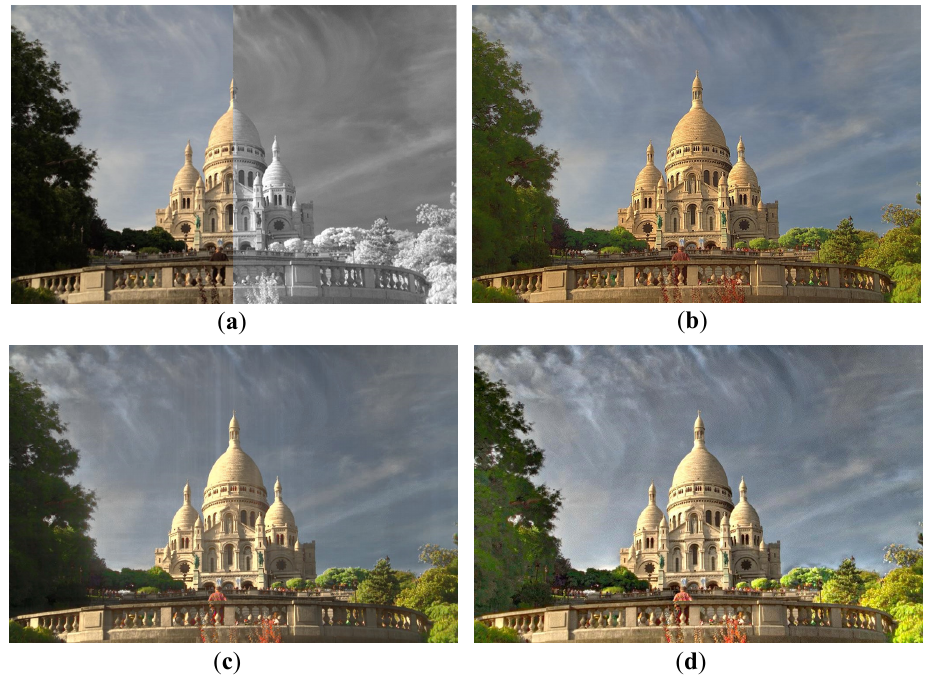
Figure 10. Input image pair and resulting images: ( a ) input VIS and NIR images, ( b ) Laplacian pyramid fusion [1], ( c ) low-rank fusion [5], and ( d ) the proposed method.